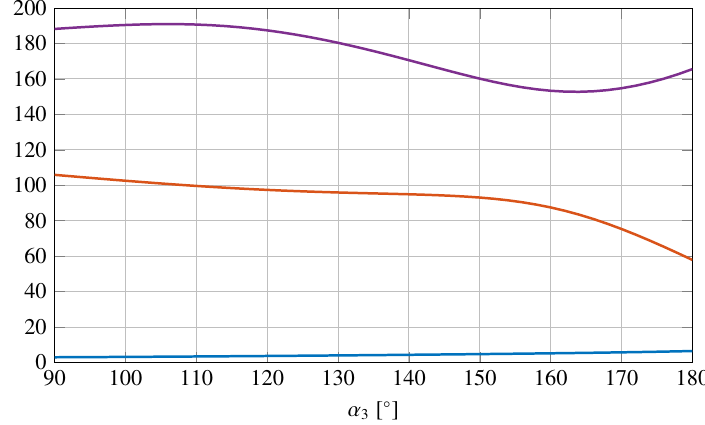
Figure 6. Configuration dependent natural frequencies of vibration modes from one to three of the three-point linkage, as function of the angle α 3 of the input crank. First natural frequency ( ); Second natural frequency ( ); Third natural frequency (